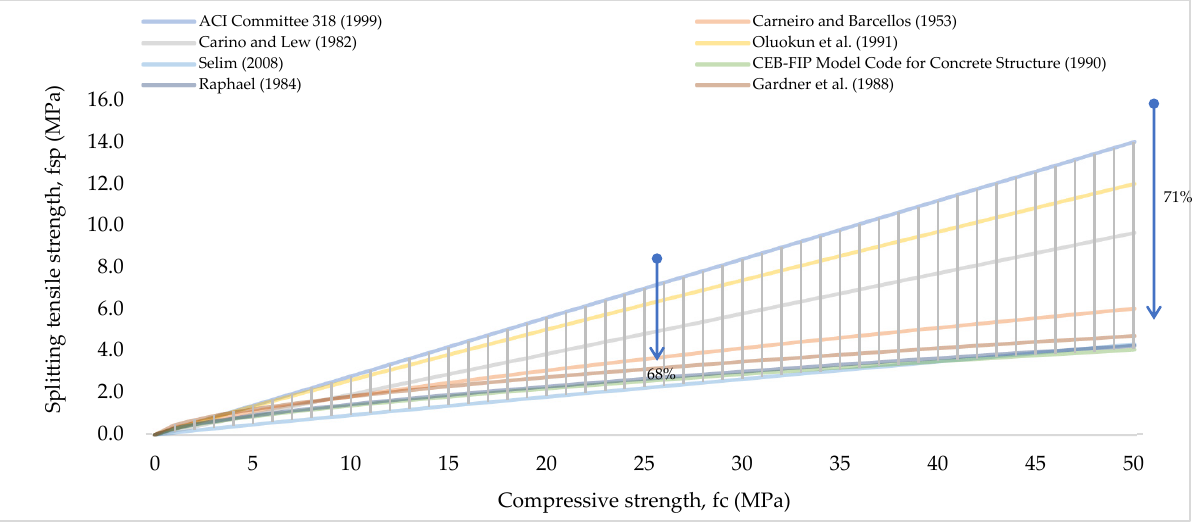
Figure 4. Correlation between Splitting tensile strength and Compressive strength (Equations (17)–(24)) [47].